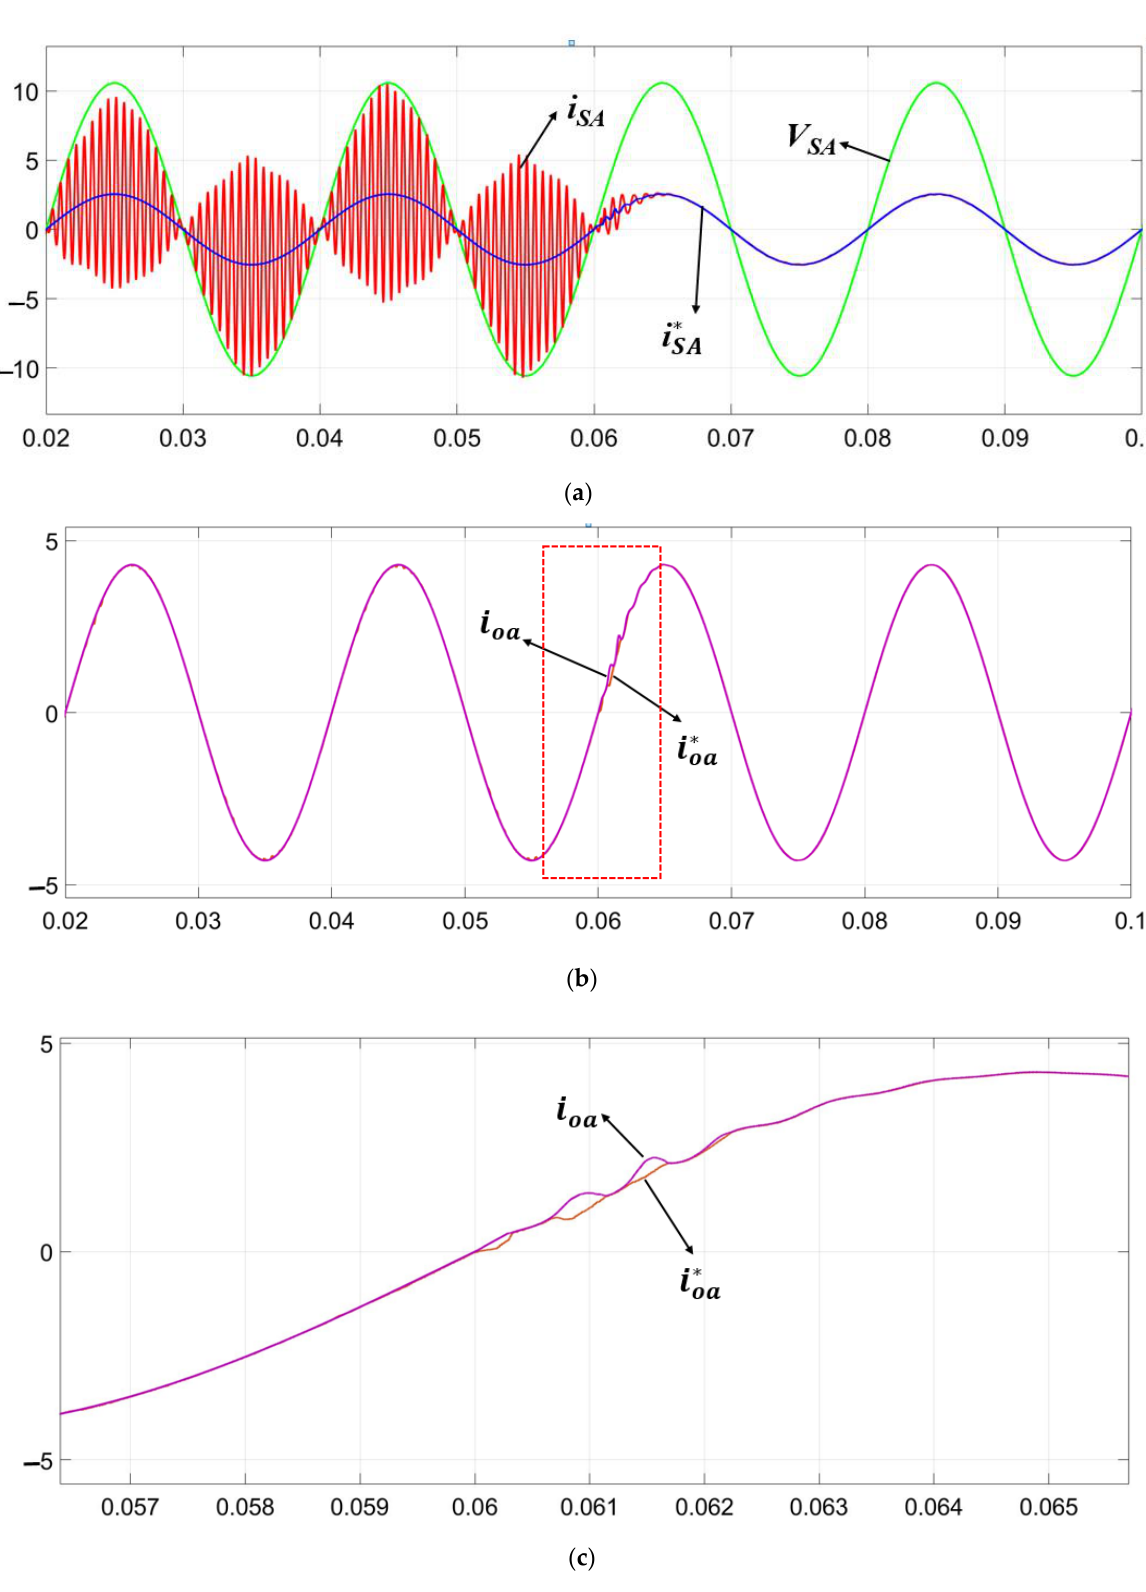
( b ) Figure 6. Possible input filter resonances. ( a ) Series resonance. ( b ) Parallel resonances. In this paper, the resonant frequency is designed and situated nearly at the seventh harmonic of the source system to excite the resonant situation, in which the TSMC system performance can be compared with the IFRS and without the IFRS. 𝑓 𝑟𝑒𝑠 = 1 2𝜋 √ 𝐿𝐶 ≈ 7(pu) (51) The source voltage and current, and the source-current reference of the input phase A are demonstrated in Figure 7a, and the output current and its reference of the output phase a are shown in Figure 7b. As can be seen from Figure 7, the IFRS is added at t = 0.06 s. Before that, the source current is highly distorted because of the resonance of the input filter. In contrast, the source current is greatly improved with an almost sinusoidal wave- form after t = 0.06 s, achieving a very good tracking to its reference. At the same time, an almost sinusoidal waveform of the output current is obtained in Figure 7b, approaching its reference. Figure 8 shows the results of another simulation group, where the output-